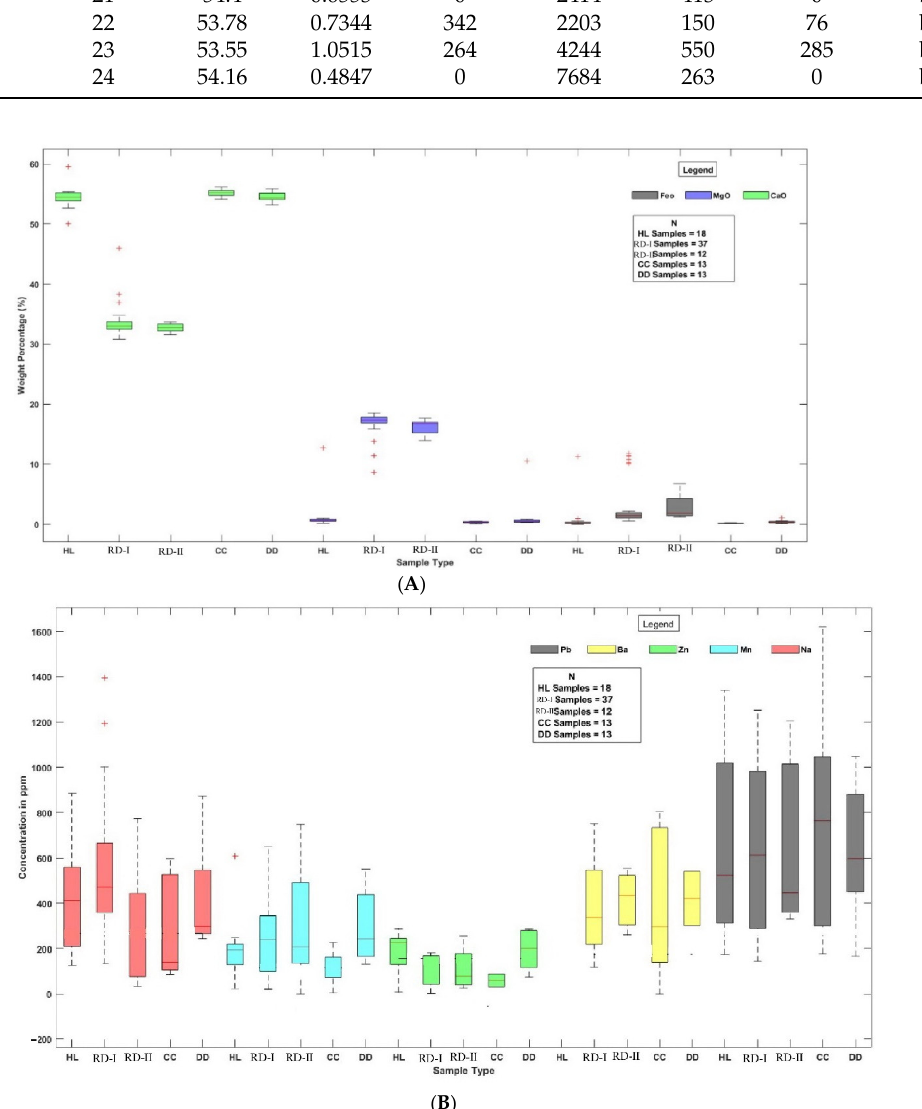
Figure 5. The box plot shows the concentration of major and trace elements of different dolomites and other diagenetic phases observed. ( A ) The box plot shows the concentration of major elements expressed in weight percentage. ( B ) The box plot shows the concentration of minor elements expressed in ppm. HL: host limestone, RD-I: matrix dolomite, RD-II: replacive dolomite, CC: fracture- filling calcite, DD: dedolomite.